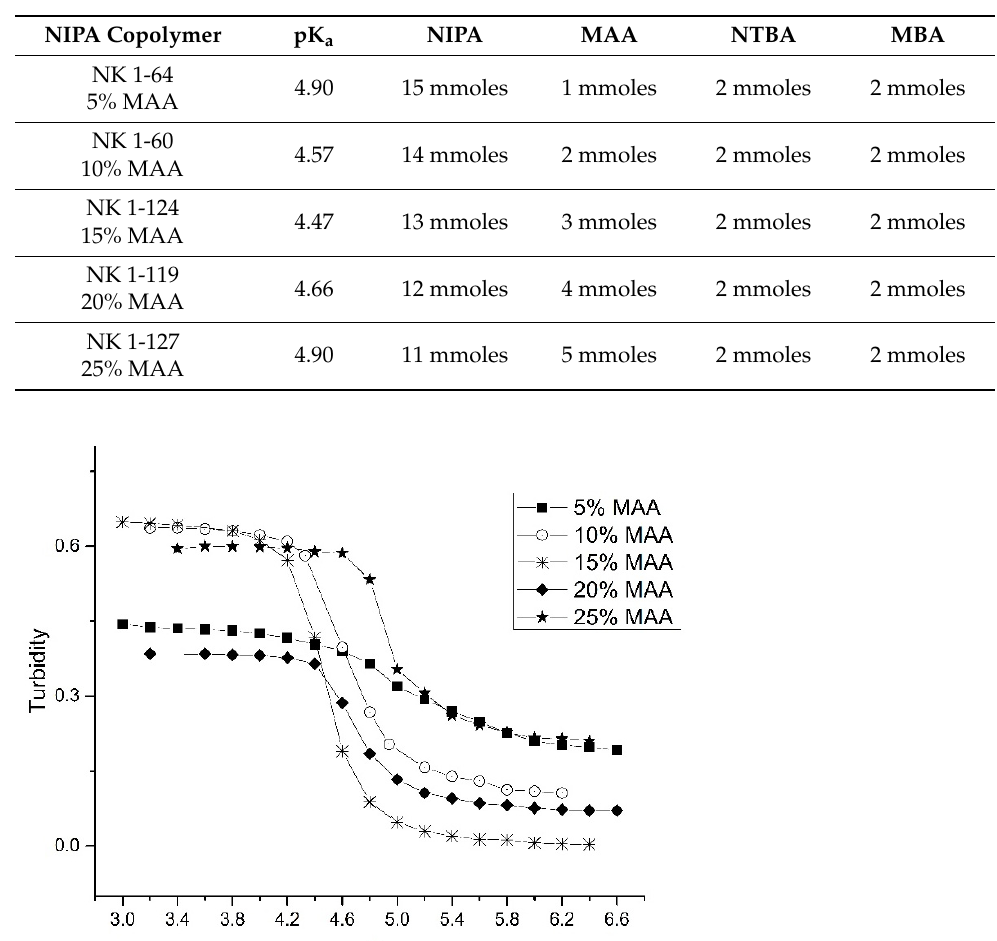
Table 3. Optimum Amount of MAA in Formulation.